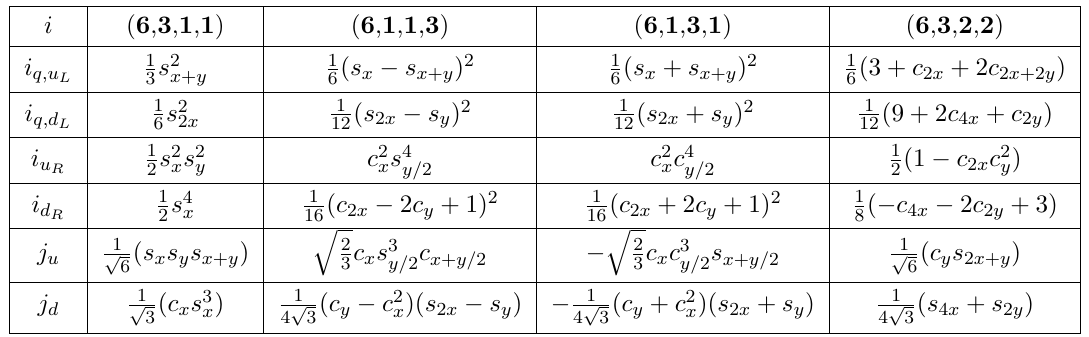
Table 1 . Invariants evaluating the NGBs in their vevs, with s z = sin z , c z = cos z , x = v=f + p p v 4 = ( f 2) and y = v=f (cid:0) 2 v 4 =f . The columns are associated to representations R present in the decomposition of 286 under